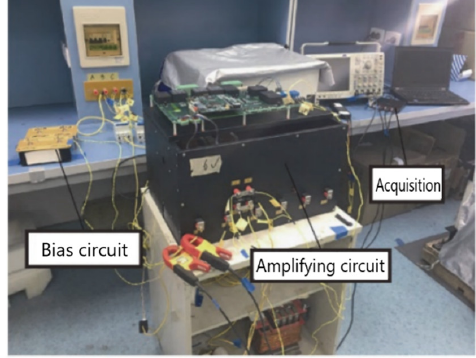
Figure 4. IGBT low-frequency noise test environment.